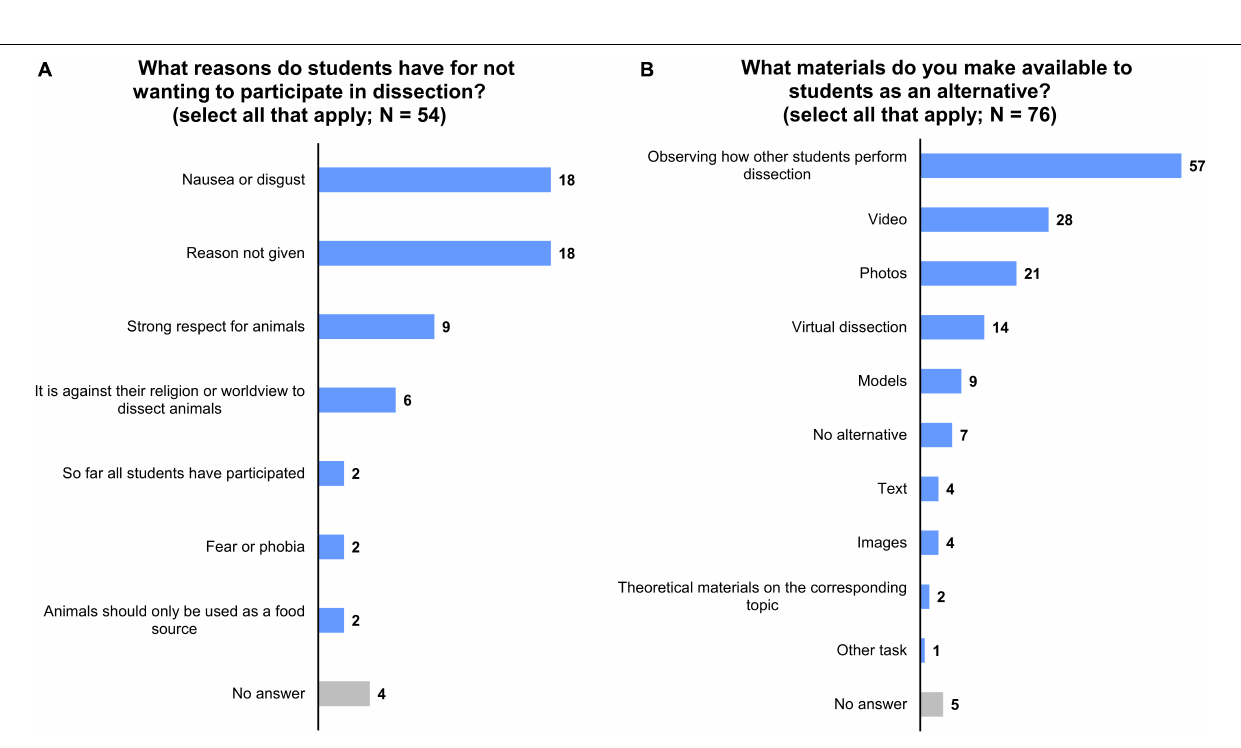
FIGURE 5 | (A) Reasons of students for not participating in dissection. (B) Alternatives provided by the respondents to students not wanting to participate in dissection.